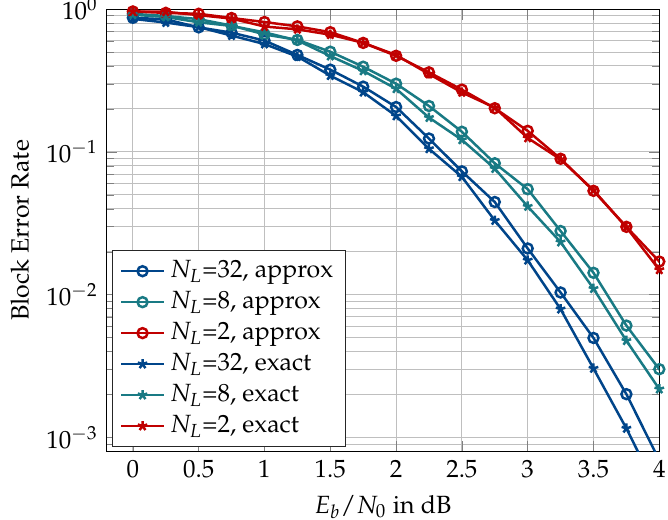
Figure 22. Effect of using the approximation path metric update rule of Equation (10) on the block error rate of a 4-bit information bottleneck decoder with N L = 2,8 or 32, 16-bit CRC, N = 128, rate 0.5, and design E b / N 0 = 3